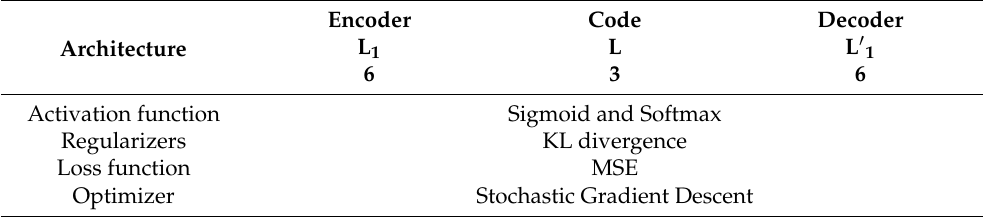
Table 6. DS2AN model details.